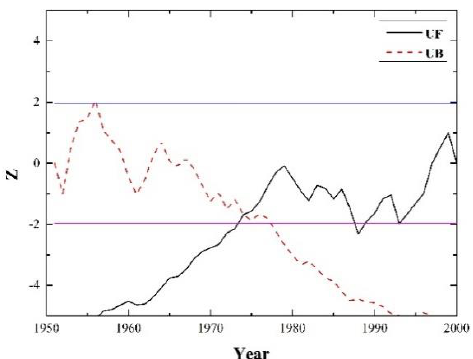
Figure 6. Mann-Kendall abrupt change point test of runoff at the Guantai Station.